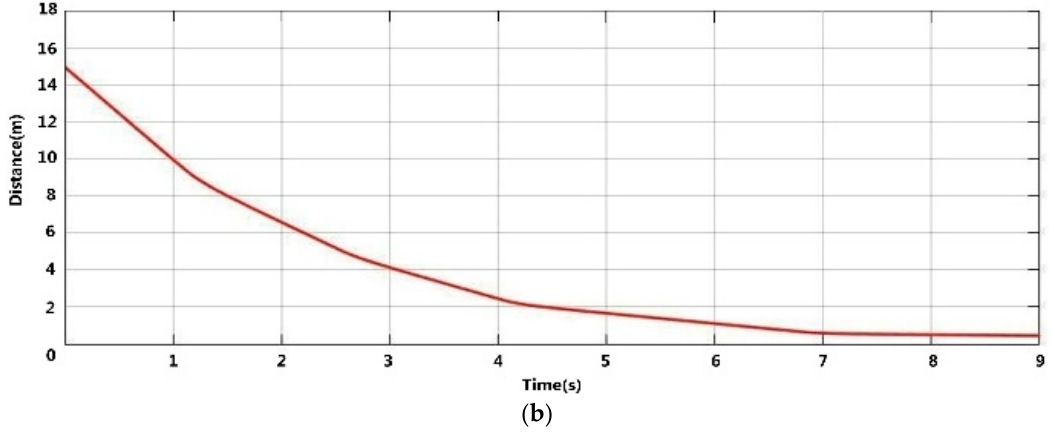
Figure 23. Simulation results of the proposed vehicle reversing speed control. ( a ) Relationship between speed and time; ( b ) Relationship between distance and time.